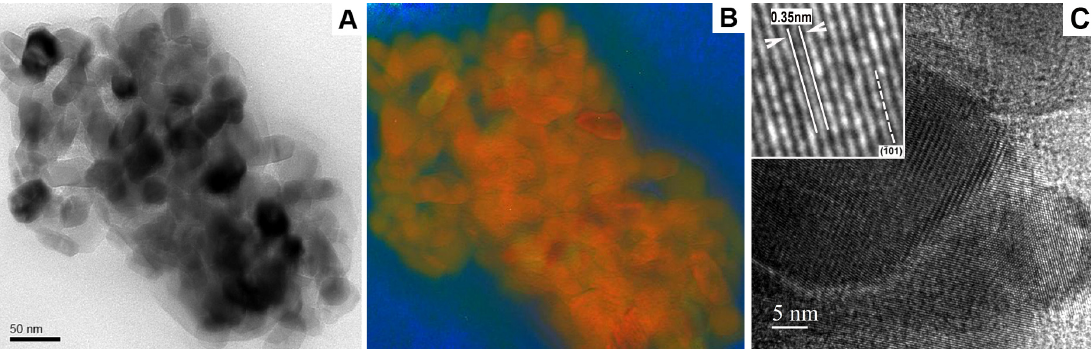
Figure 3. Characterization of the model macroemulsion with incorporated titanium dioxide particles by conventional zero-loss filtered bright field TEM ( A ) and EFTEM ( B ); The RGB EFTEM image shows the superimposed elemental maps of carbon (blue), titanium (red) and oxygen (green); ( C ) High resolution bright field TEM image of titanium dioxide particles. The scale bar represents 50 nm in ( A , B ) and 5 nm in ( C